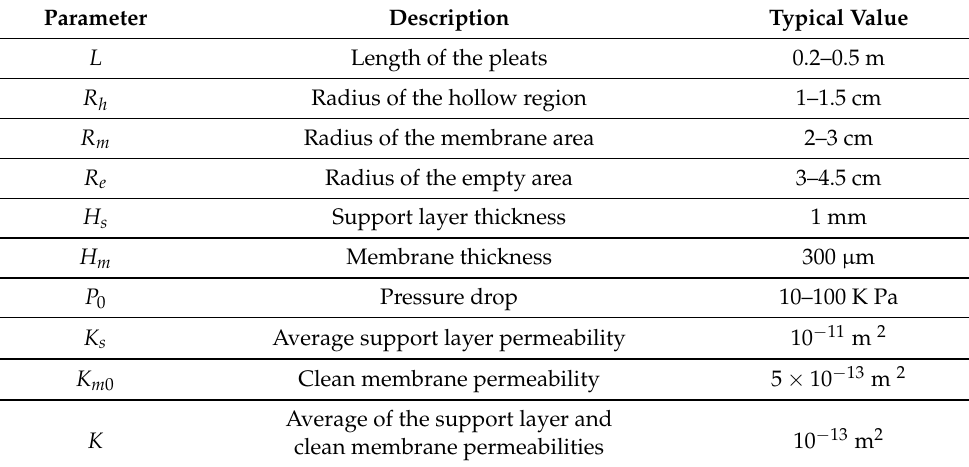
Table 1. Dimensional parameter values